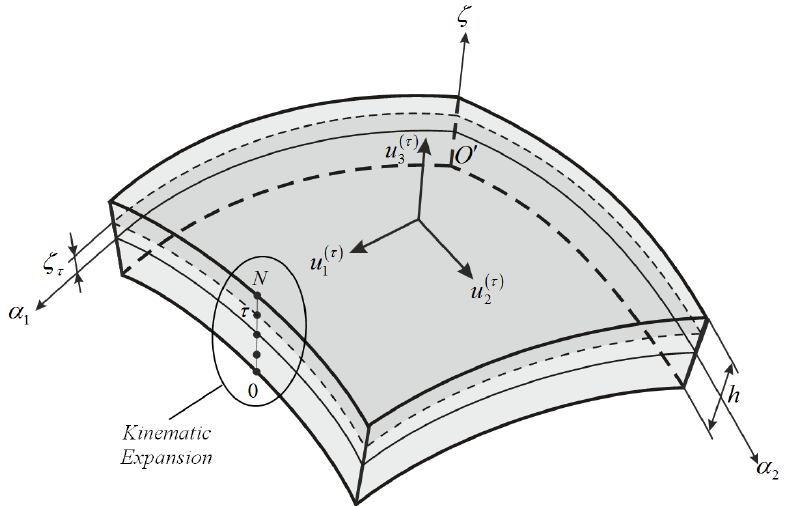
Figure 2. Kinematic expansion and degrees of freedom related to the order for the Equivalent Layer-Wise (ELW) approach.